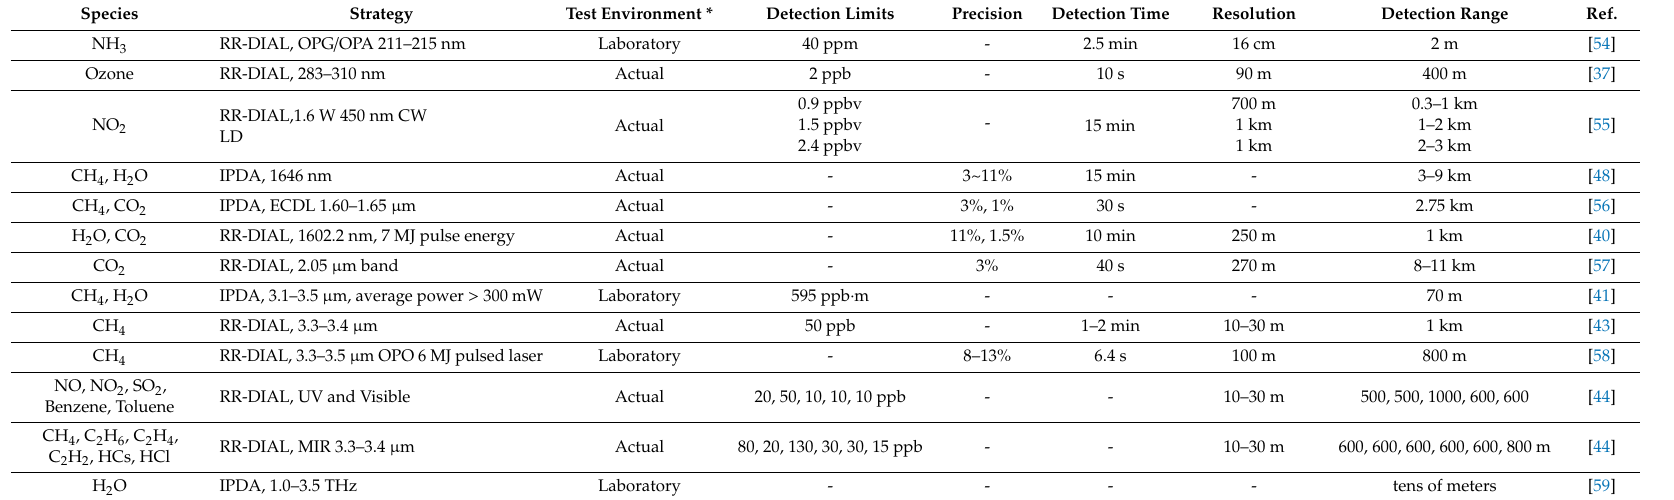
* Test environment denotes that the performance evaluation of the corresponding detection was conducted under laboratory or actual